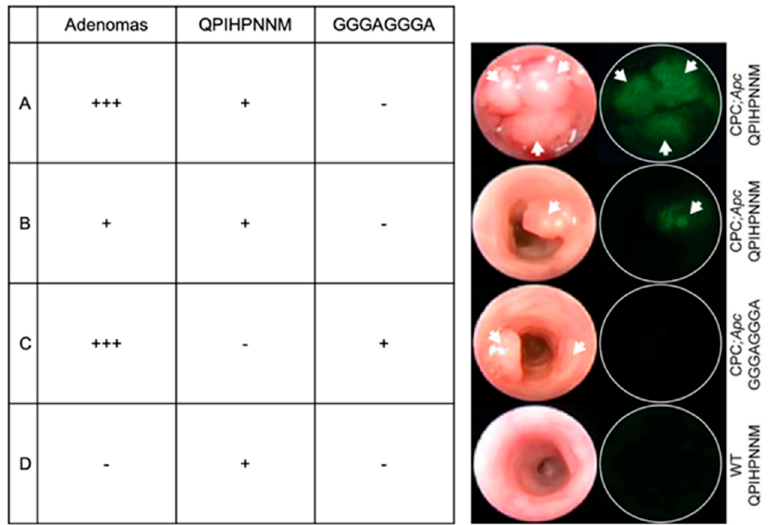
Figure 2. Wide-field endoscopy images acquired after in vivo incubation (5 min) of fluorescently labeled peptide QPIHPNNM in a genetic mouse model of adenoma formation in the colon. The left column shows white light images and the right column shows fluorescence images for binding of ( A ) QPIHPNNM to colon tissue with multiple adenomas, ( B ) QPIHPNNM to colon tissue with one adenoma, ( C ) control peptide GGGAGGGA to colon tissue with multiple adenomas, and ( D ) QPIHPNNM to lumen of colon tissue of a wild-type (WT) mouse. In the model shown, CPC: Apc , Cre recombinase is linked to the Cdx2 promoter and floxed APC ( adenomatous polyposis coli ). Images modified from [10] and used with permission from PLoS ONE.